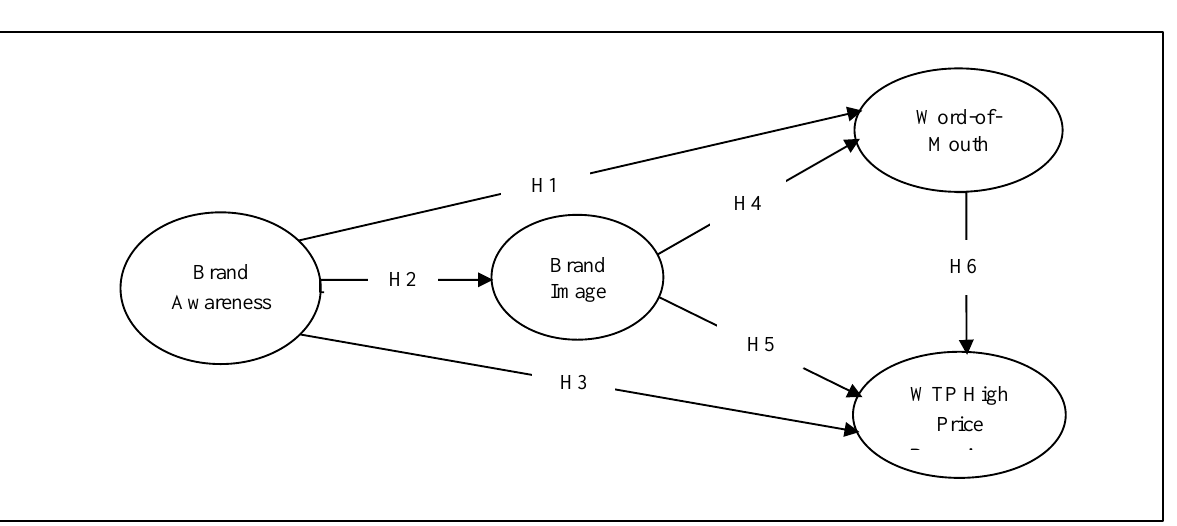
Figure 1: Research Model; Source: Developed by